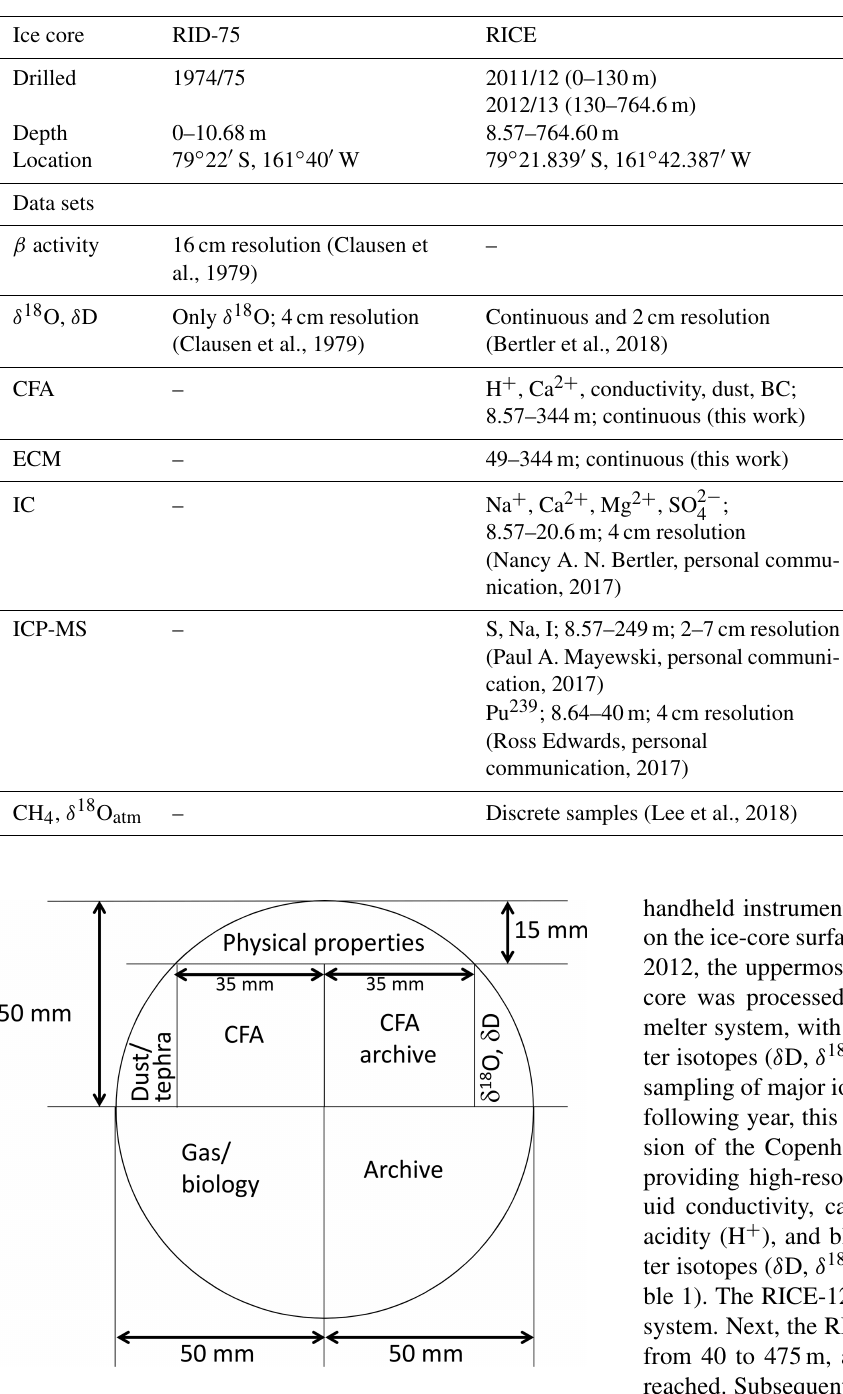
Figure 2. The cutting plan for the RICE main core included two CFA sticks of size 35 ×